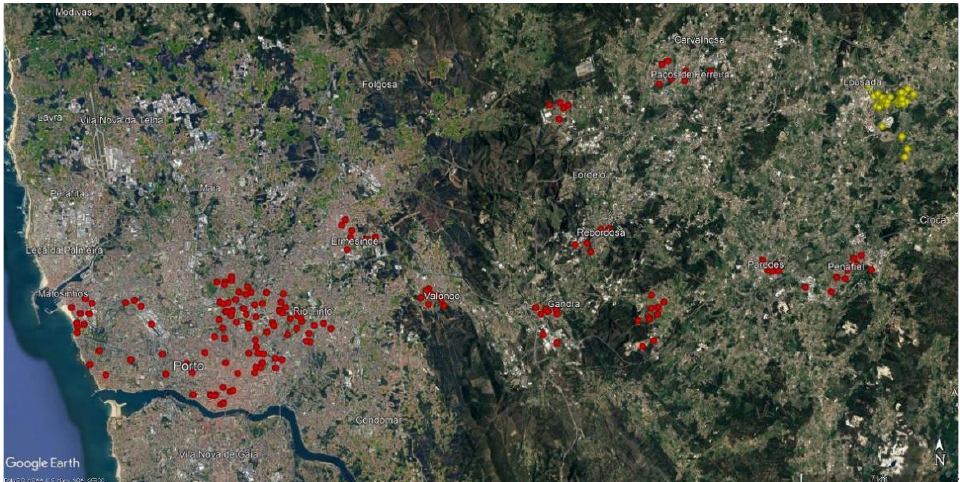
Figure 4. Geographic location of the members under study (Google Earth Pro) (red dots are the Created Members-, yellow dots are the Real Members).